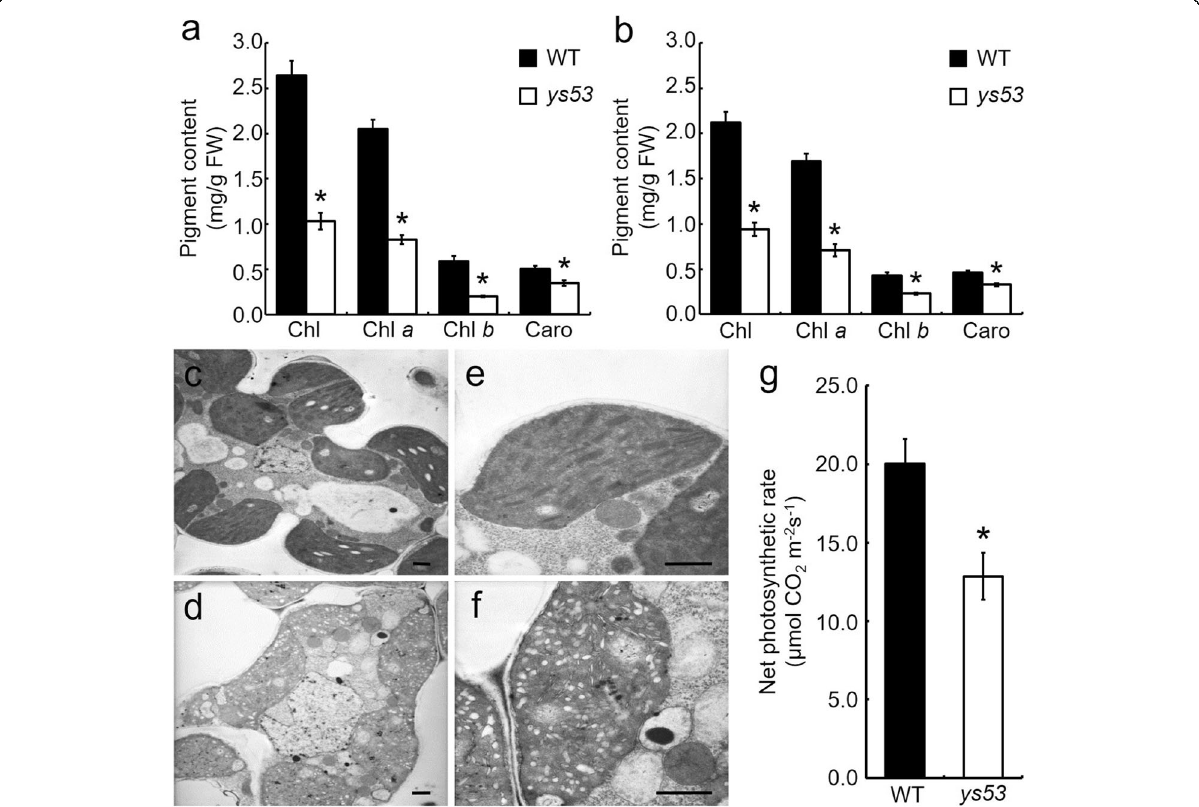
Fig. 2 Physiological characteristics of the ys53 mutant and its wild type. a and b Contents of photosynthetic pigments in leaves at seedling stage and booting stage, respectively. c and d Mesophyll cells of the wild type and ys53 , respectively. e and f Chloroplasts of the wild type and ys53 , respectively. g Net photosynthetic rate at grain-filling stages. Data are means ± SD ( n =3). Error bars represent (SDs) standard deviations of three independent experiments. * indicate statistically significant differences compared to the wild type at P <0.05. Chl: chlorophyll. Caro: carotenoids. Scale bar=1 μ m